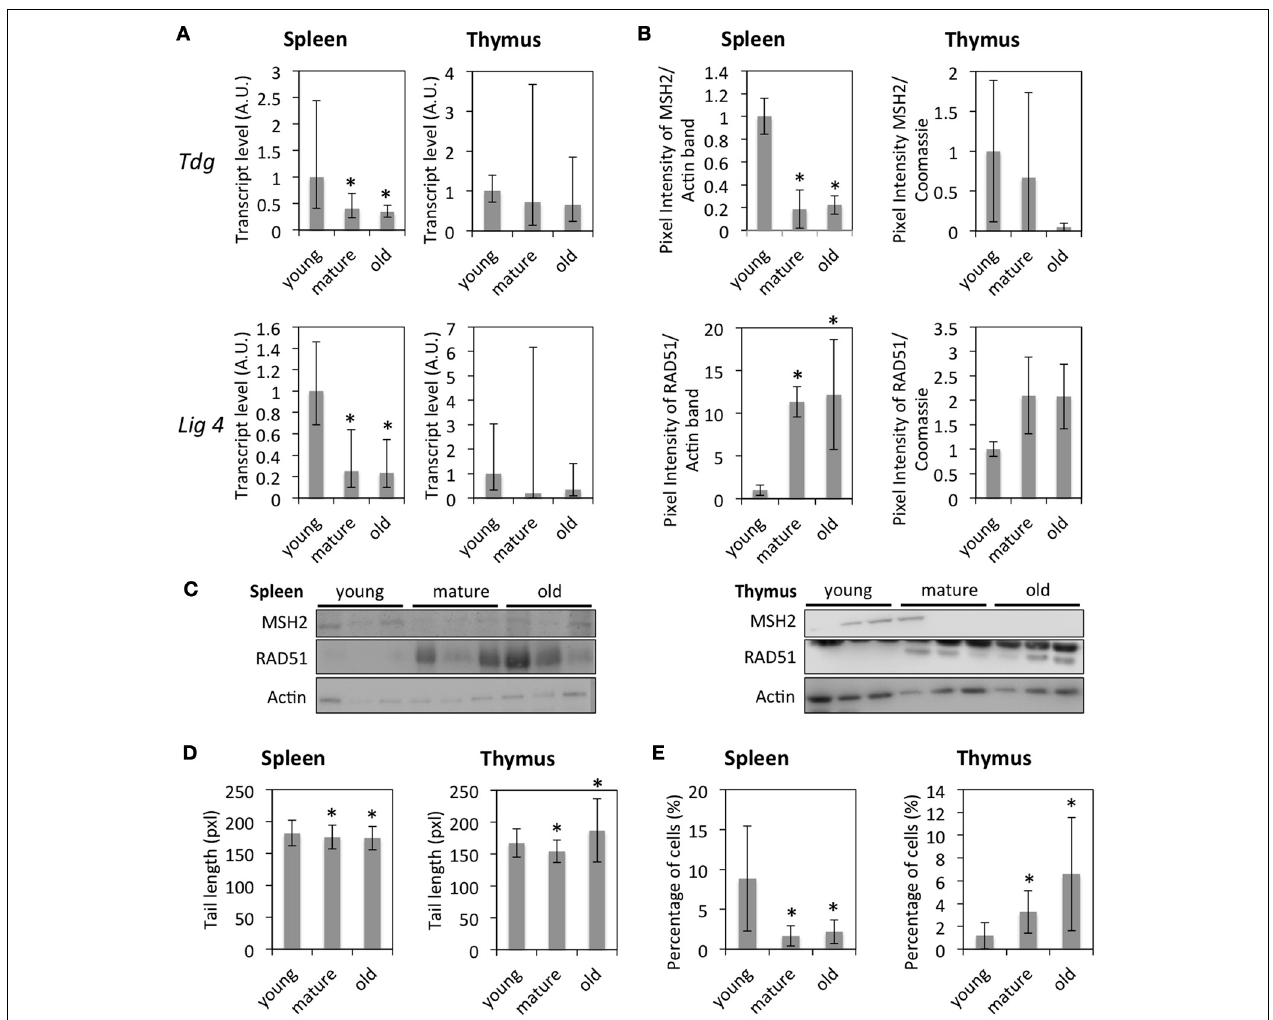
FIGURE 5 | Age-dependent changes in DNA damage and repair. (A) mRNA fold expression changes normalized to a set of housekeeping genes and the expression in young animals as determined by qRT-PCR. The bars represent means ± 95% confidence intervals. (B) Protein expression levels for selected genes measured by Western blot. The bars represent means normalized to the Actin expression levels and the expression in